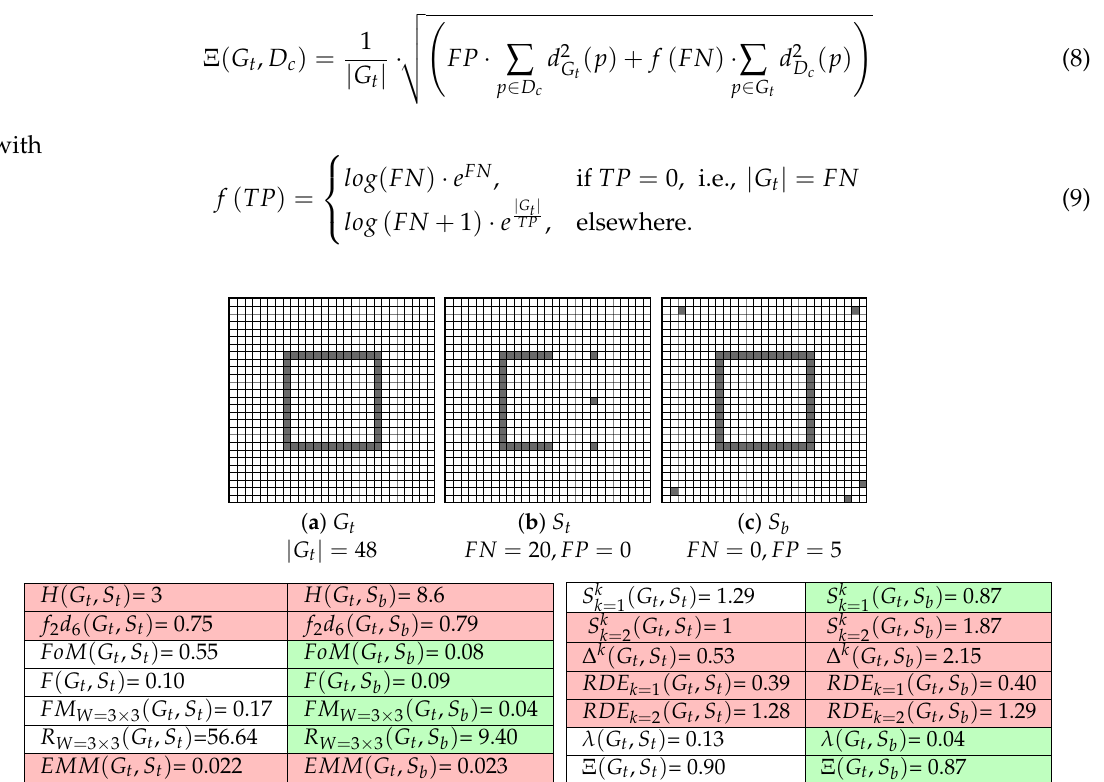
Figure 12. A single (or a few) FP point(s) at a sufficiently high distance may penalize a good detection. S b represents G t in ( a ) with only five FPs that penalize the shape using several edge detection evaluation